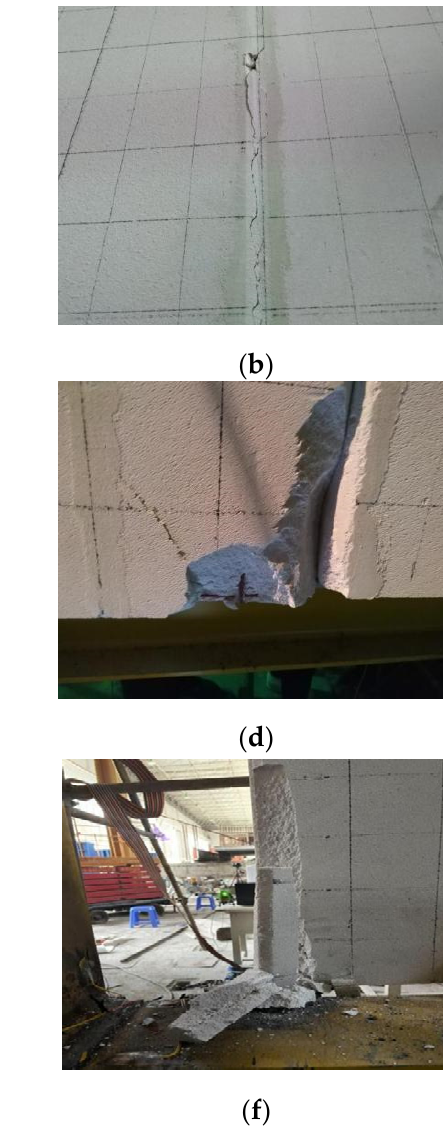
Figure 12. Crack pattern of specimen FW1: ( a ) splice mortar crack; ( b ) transverse crack in mortar; ( c ) dislocation of wall panels; ( d ) crack of the corner; ( e ) weld fracture; ( f ) large area of broken panel corner.